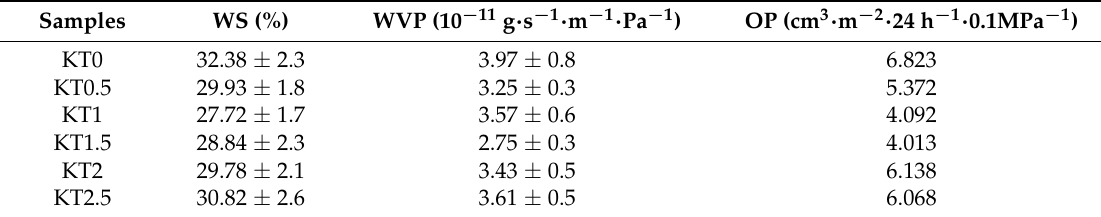
Table 1. The water vapor permeability, solubility, and oxygen permeability of the composite films (KT0.5~KT2.5).